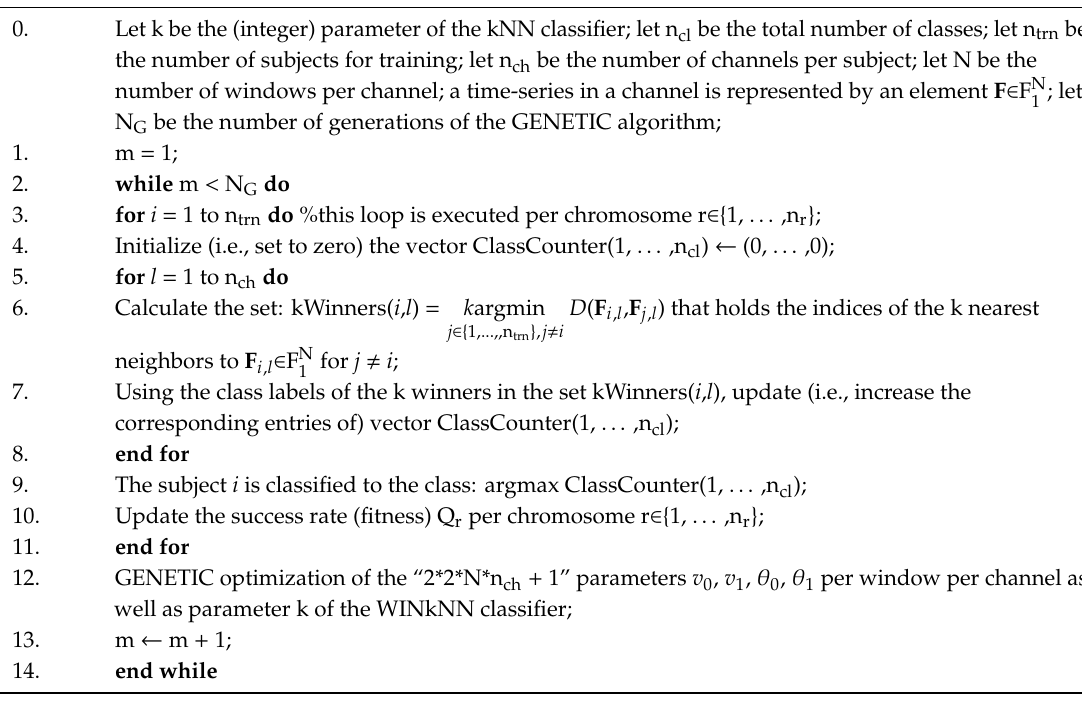
Algorithm 1 Windowed Intervals’ Number kNN (WINkNN) classifier for